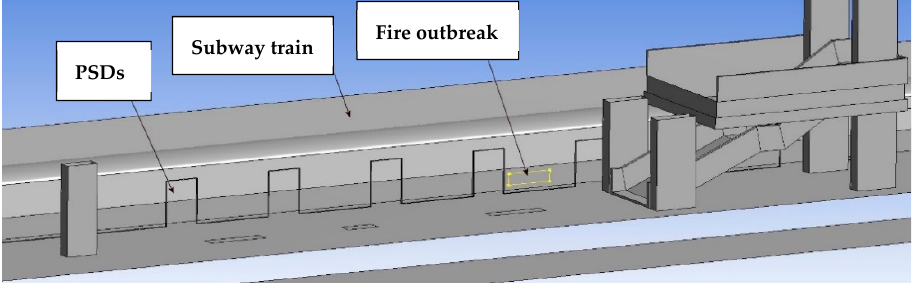
Figure 3. Location of the fire source.